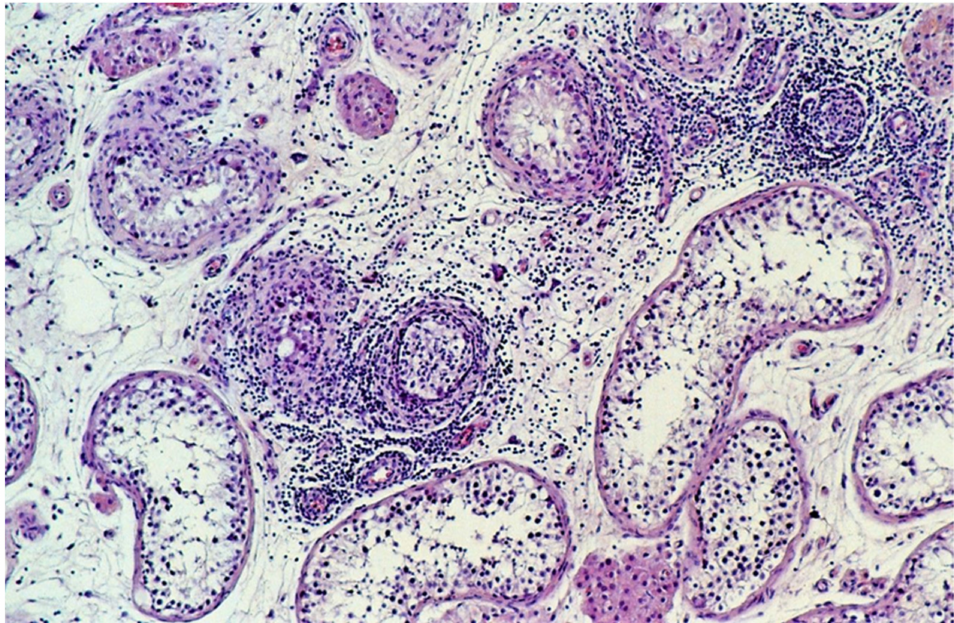
Figure 1. Tubules with infiltrating lymphocytes. The lymphocytic host response targets tubules with GCNIS, not the tubules with spermatogenesis. The diameter of the tubules decreases as GCNIS is gradually cleared. (hematoxylin and eosin staining, × 100